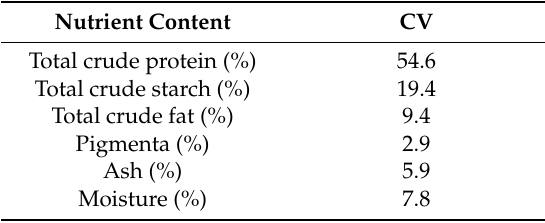
Table 1. Nutrient content of Chlorella vulgaris